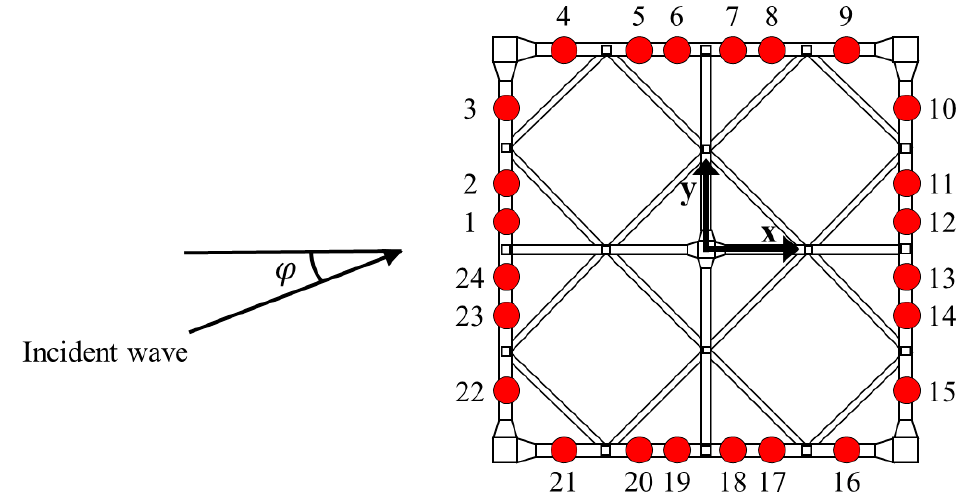
Figure 7. Platform and multiple WEC array configuration and incident wave direction.